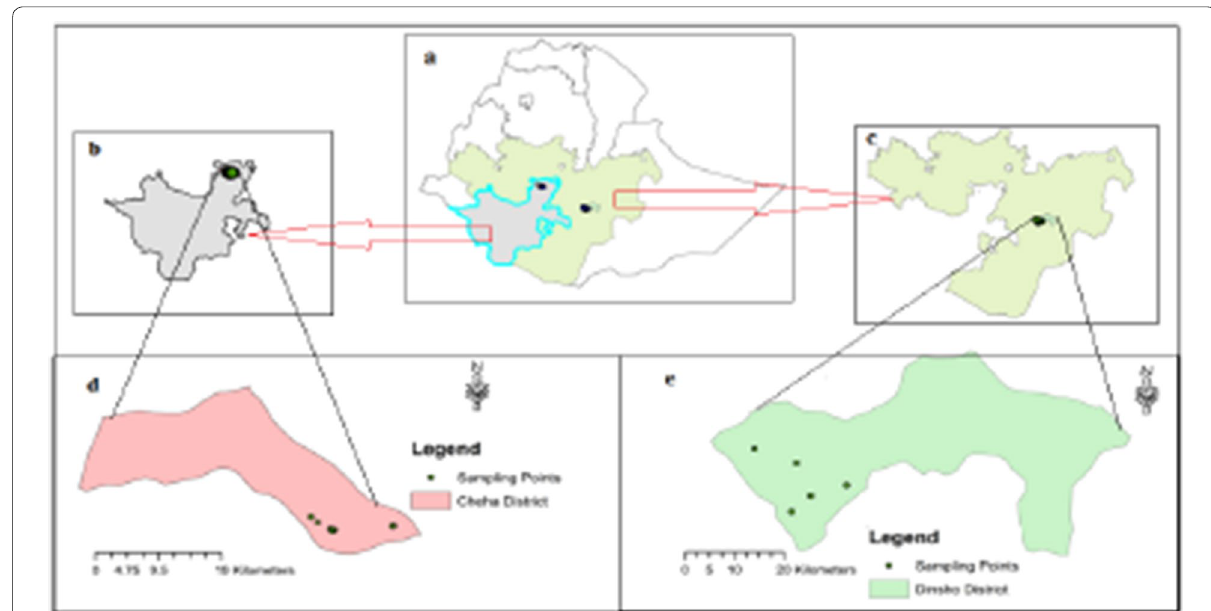
Fig. 1 Location map of the study areas, a Oromia and SNNP regions in Ethiopia, b Cheha district in SNNP region, c Dinsho district in Oromia region, d Cheha district, e Dinsho